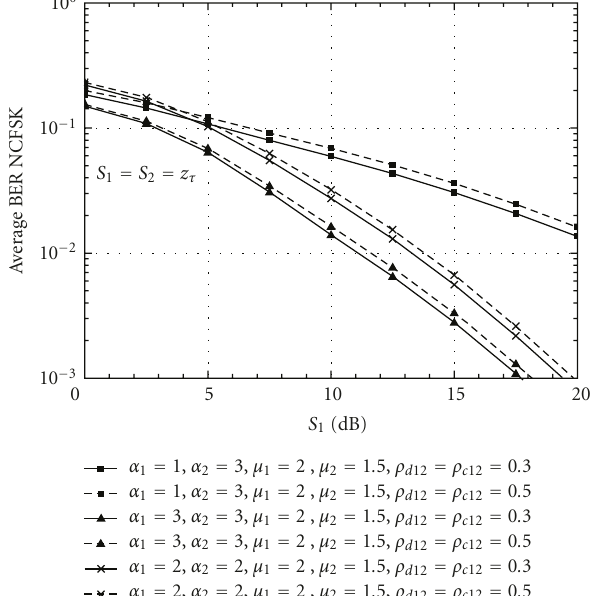
Figure 2: Average bit error probability (ABER) versus average SIRs at the input branches of the balanced dual-branch switched- and-stay combiner, S 1 , for NCFSK modulation scheme and several values of ρ 12 d , ρ 12 c , μ 1 , μ 2 , α 1 , and α 2 .